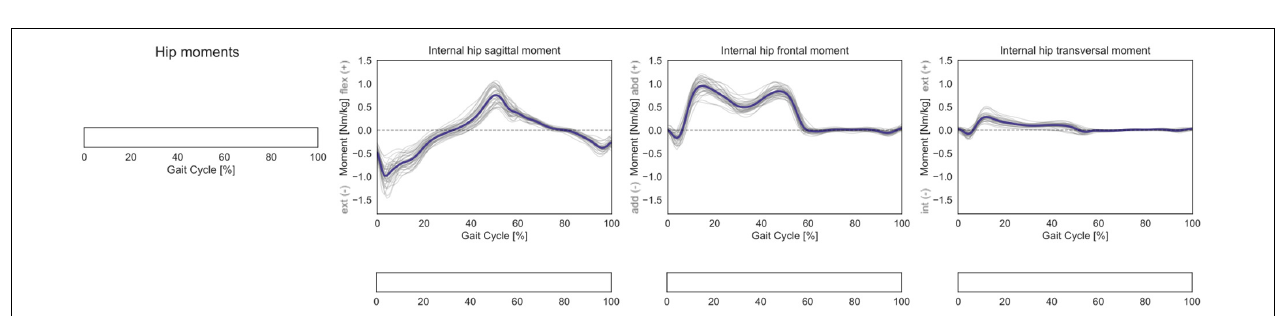
FIGURE 5 | Hip 3D kinematics and foot progression angle over the GC. Average profiles for each subject are reported in gray, while the cohort’s mean is reported in turquoise. For the hip joint 3D kinematics, phases of GC in which a statistically significant correlation was observed in the SPM vector-field CCA are indicated in the leftmost panel. Below each kinematic component, the results of the post hoc scalar-field linear regression analyses are reported. For the foot progression angle, the phases of GC in which a statistically significant correlation was observed in the SPM scalar-field linear regression analysis are indicated in the leftmost panel.